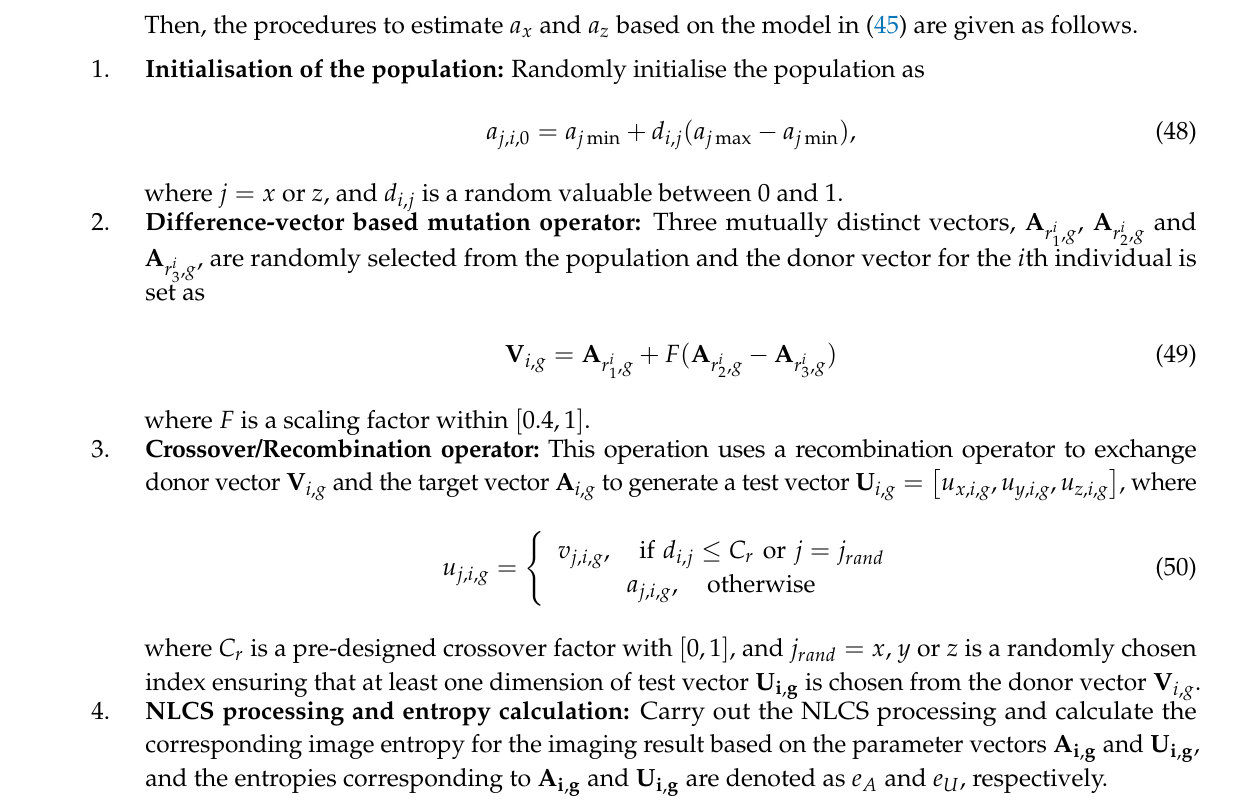
Figure 4. Flowchart of the motion estimation on